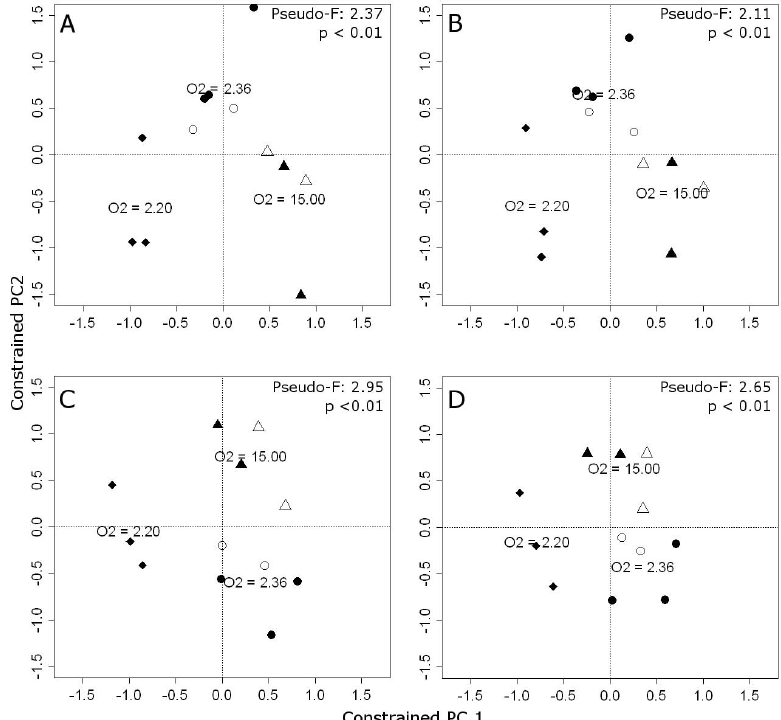
Fig. 7. Constrained ordinations models of macrofaunal assemblage structure, determined by (A) biomass C and (B) biomass N, and the macrofaunal assimilation of (C) phyto C and (D) phyto N, at stations T1 800m (4 day, (cid:7) ) , T2 800m (4 day • , 7 day ◦ ) and T2 1100m (4 day N , 7 day 4